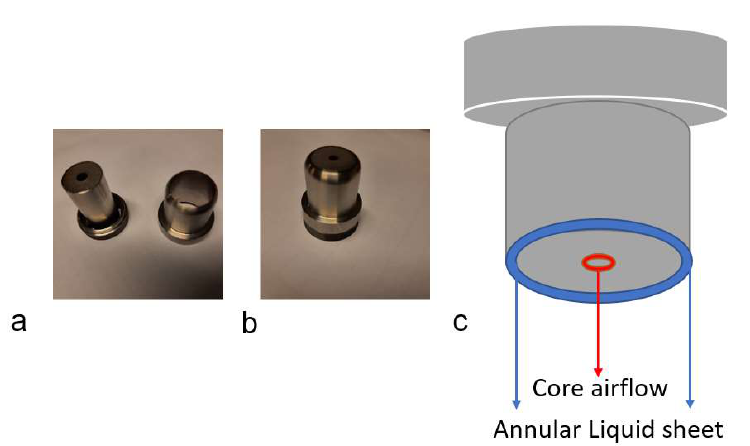
Figure 1. Experimental sonic atomizer: ( a ) atomizer body with cap, ( b ) assembled atomizer, and ( c ) nozzle schematic depicting core air and annular liquid flow.